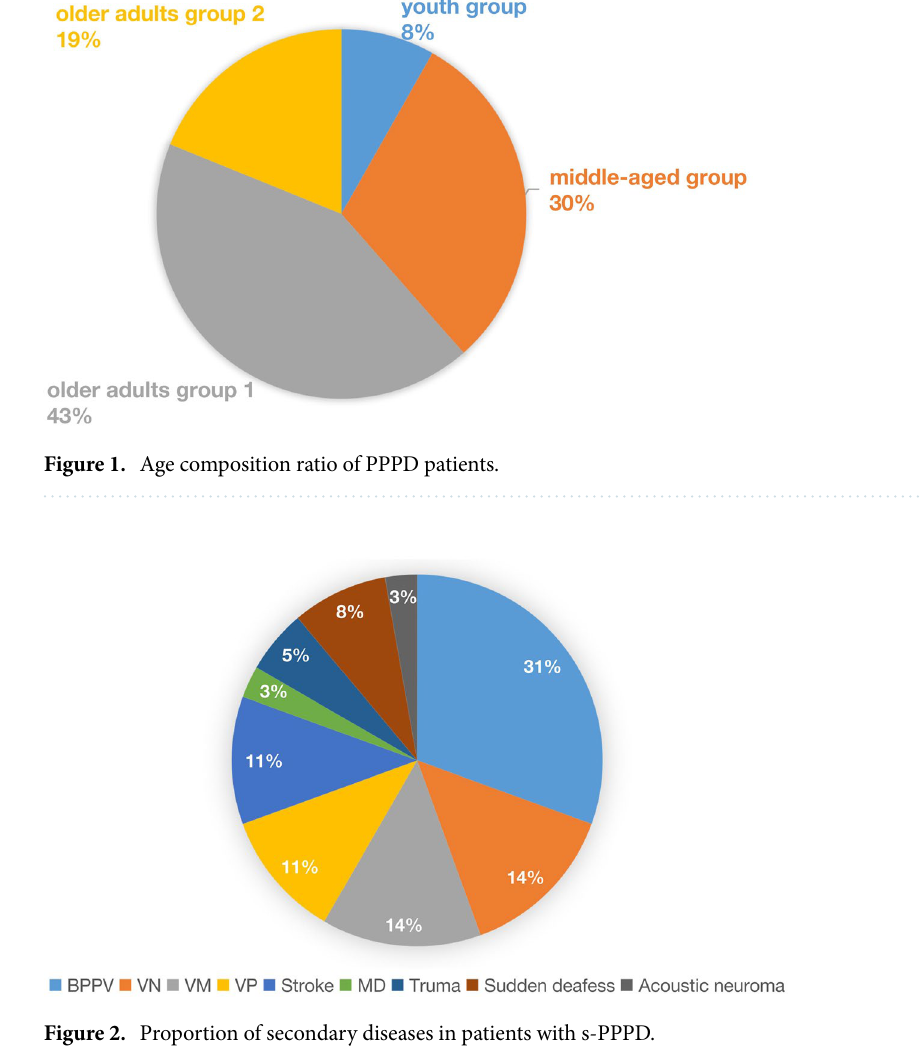
Figure 2. Proportion of secondary diseases in patients with